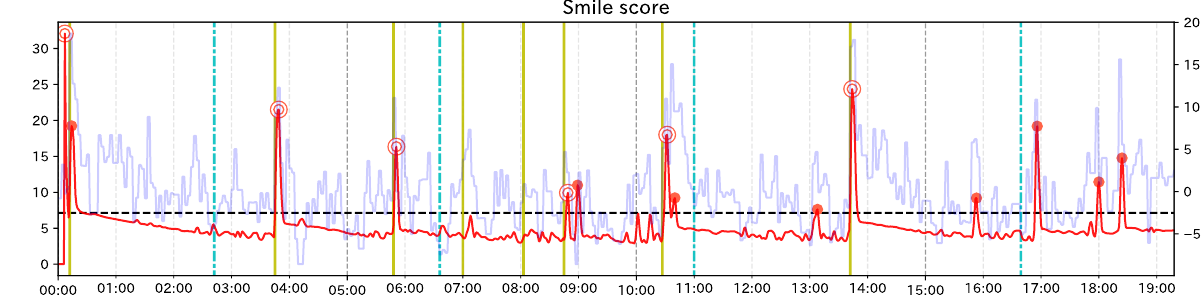
Figure 8. Graph of the change score for Smile scale (Subject A).